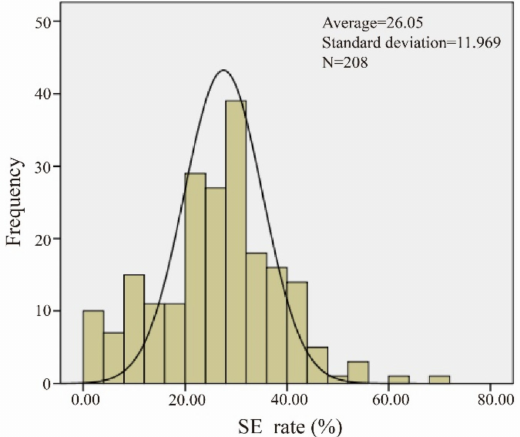
Figure 2. Normal distribution of somatic embryogenesis (SE). The data of the materials conform to a normal